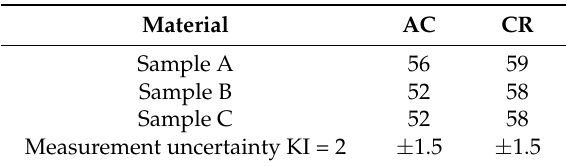
Table 6. Average hardness of the clad material (Rockwell